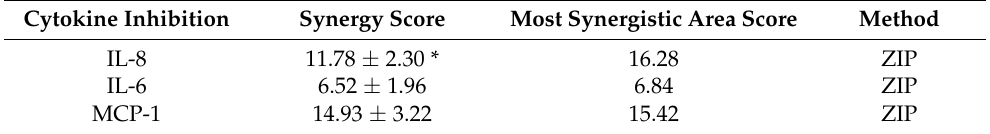
Table 1. The additive and synergistic inhibition of IL-8, IL-6, and MCP-1 induction in HCoV-OC43- infected MRC-5 cells after treatment with the combination of ciclesonide and